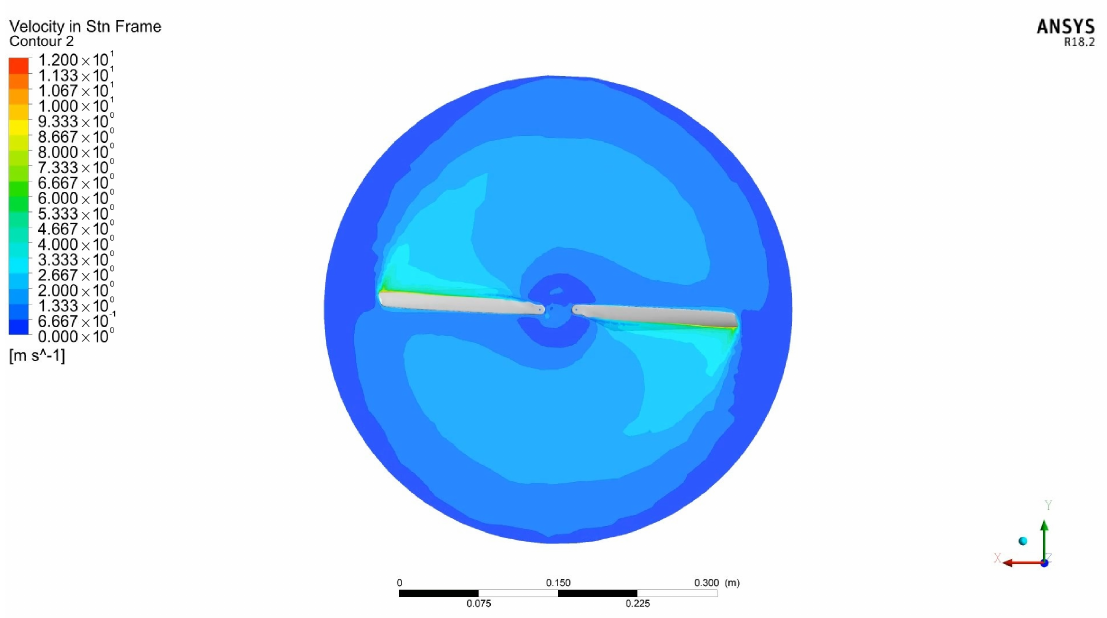
Figure 20. Fluid simulation result—velocity in stationary frame at the 0.5s